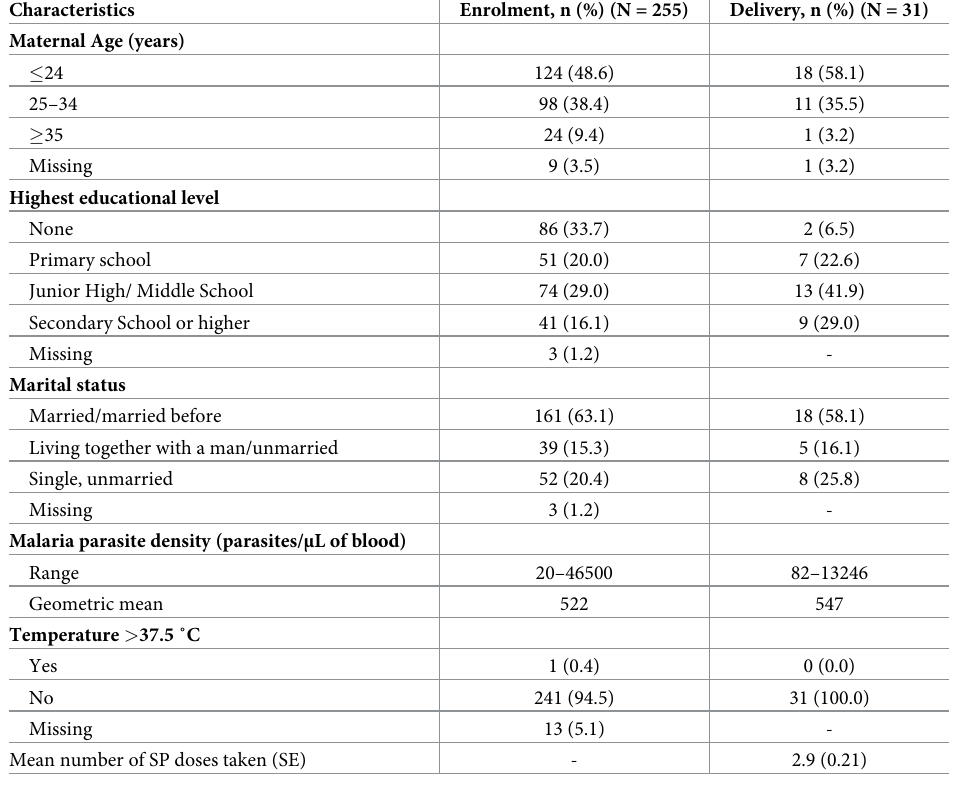
Table 1. Socio-demographic characteristics of pregnant women with malaria positive dry blood spots at first ante- natal care clinic visit or at delivery that were used in the study.